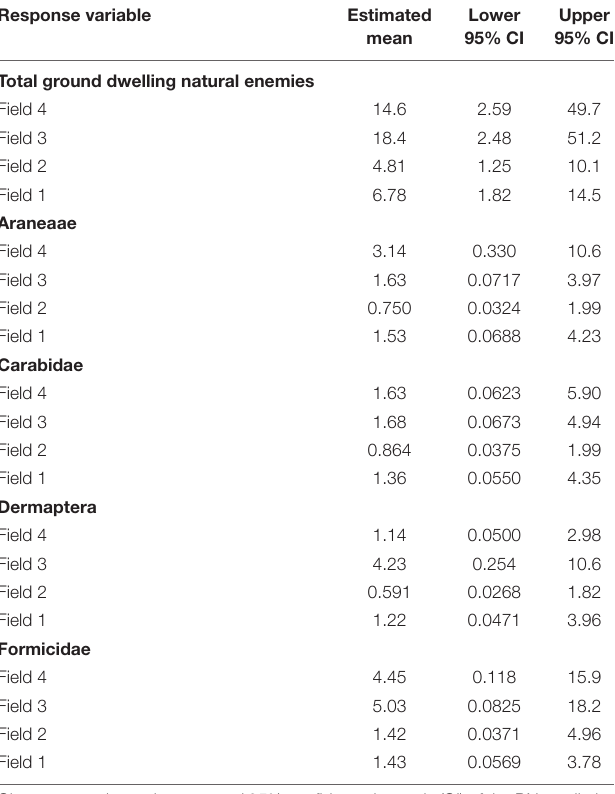
TABLE 2 | Variables explaining the abundance of ground active natural enemies and their finer taxonomic group.